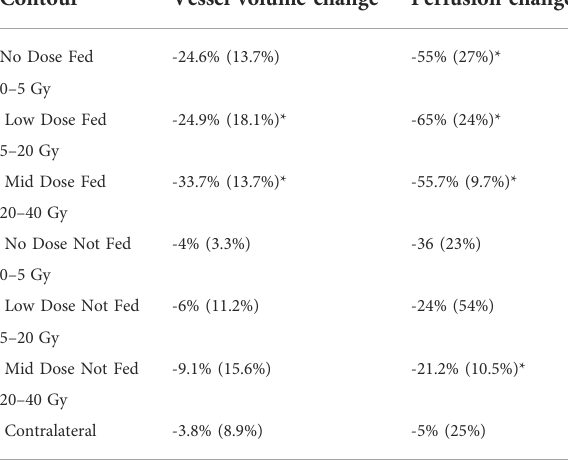
TABLE 3 Summary of vessel volume percent change and perfusion percent change in each contour analyzed. Data in the table is the sameasthedatashown inFigure 11.Entriesarewrittenastheaverage (standard deviation) of the fi ve subjects. Perfusion results are as reported in Wuschner et al. (Wuschner et al., 2022). Statistically signi fi cant values ( p < 0.05) are denoted with a